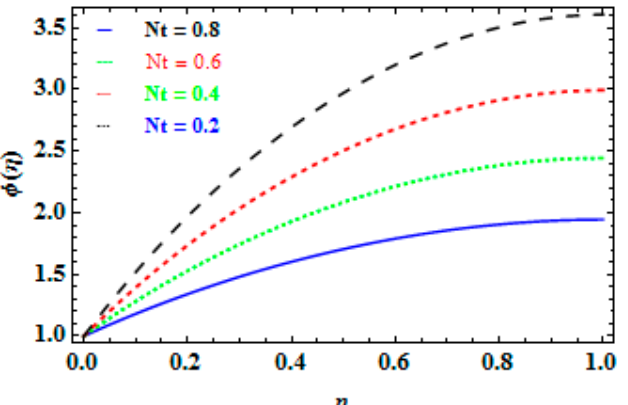
N on 𝜙 ( 𝜂 ) . N on 𝜙 ( 𝜂 ) . Figure 17. Influence of N t on φ ( η ) t t